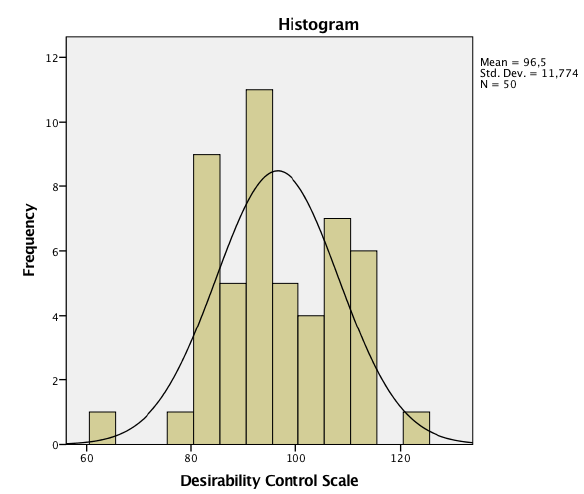
Figure 8: Desirability Control Scale population